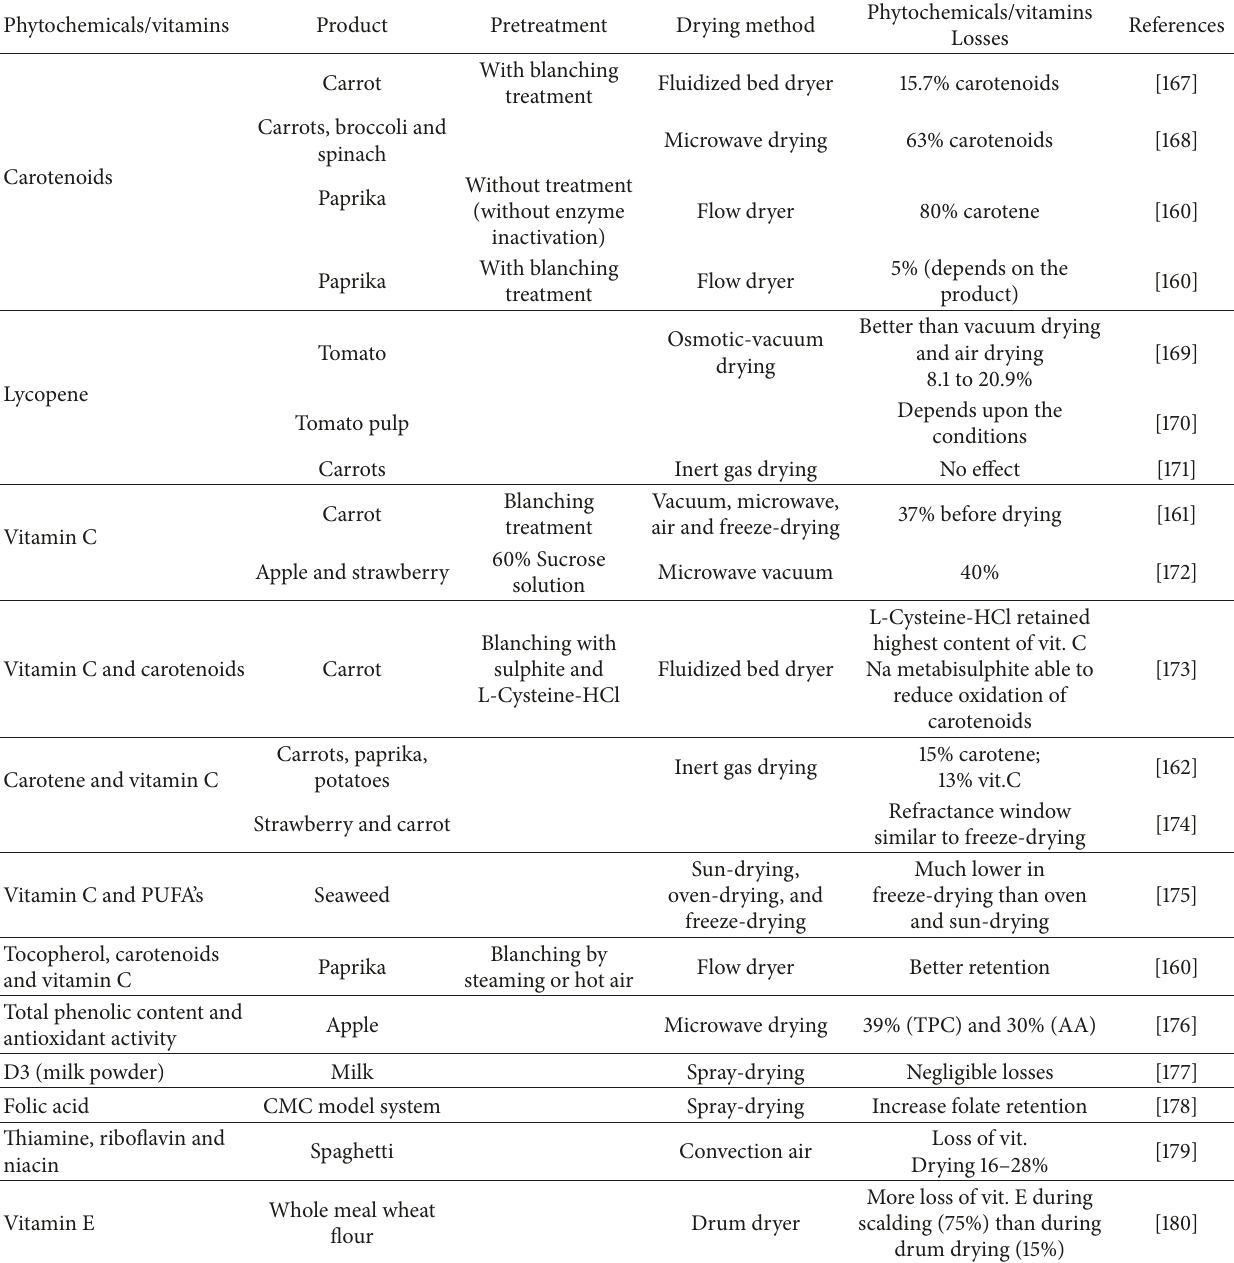
Table 7: Phytochemical losses during the pretreatment and/or drying process